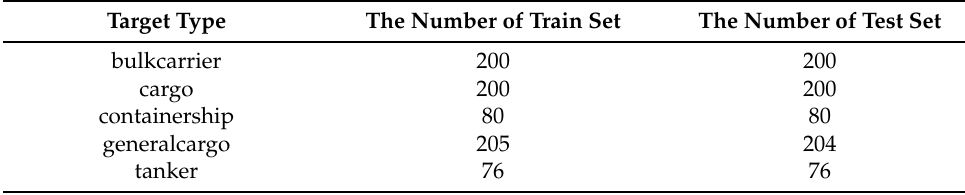
Table 2. The details of the constructed ship